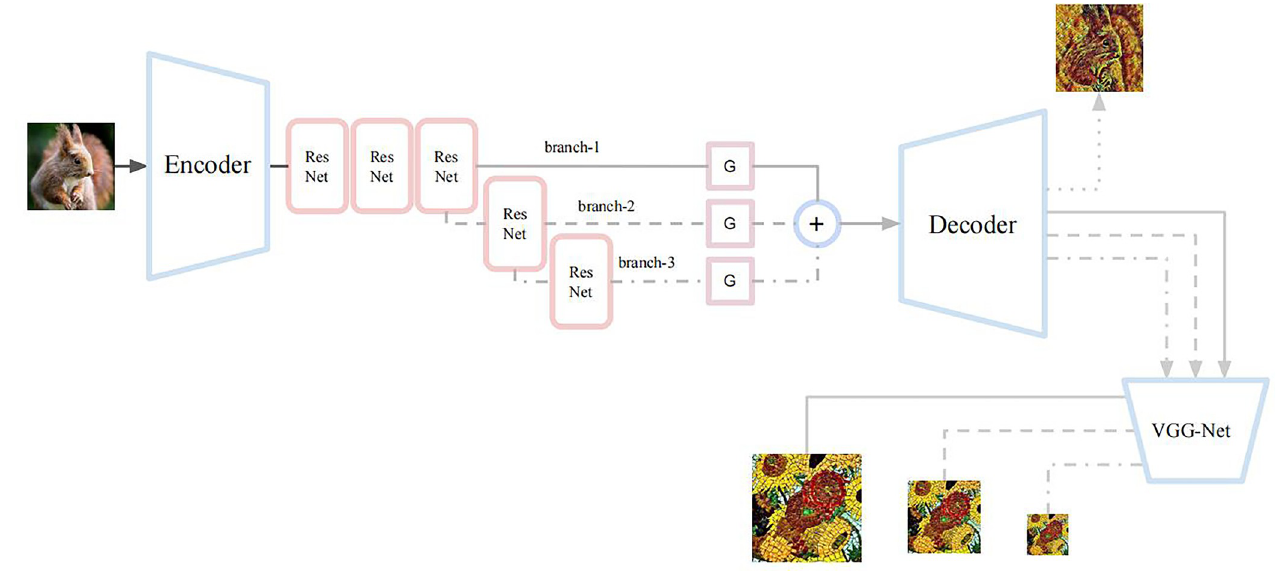
Fig 1. Stroke pyramid network